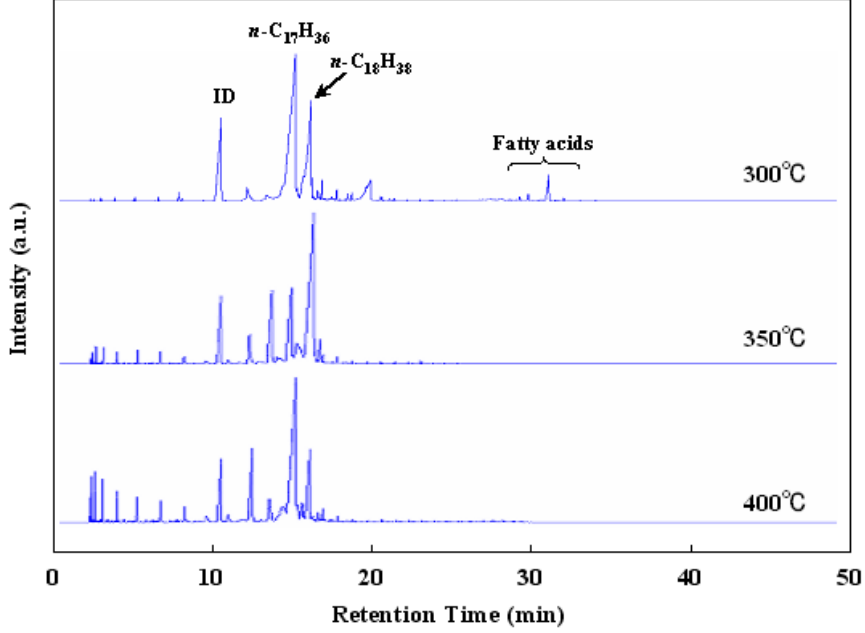
Figure 7. FID-GC charts of liquid products in the hydrotreatment of waste cooking oil -Mont at various reaction temperatures (H over Ru/Al 13 LHSV: 15.2 h –1